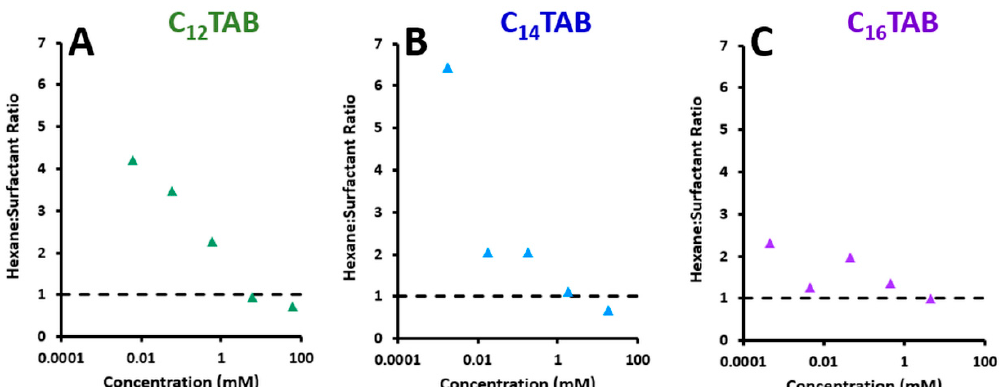
Figure 4. Surface excess molar ratios of hexane:surfactant reached at equilibrium for the interactions of hexane vapor with adsorbed surfactant monolayers analyzed from neutron reflectivity measurements involving ( A ) C 12 TAB, ( B ) C 14 TAB, and ( C ) C 16 TAB. The dashed lines simply highlight a molar ratio of unity for reference.